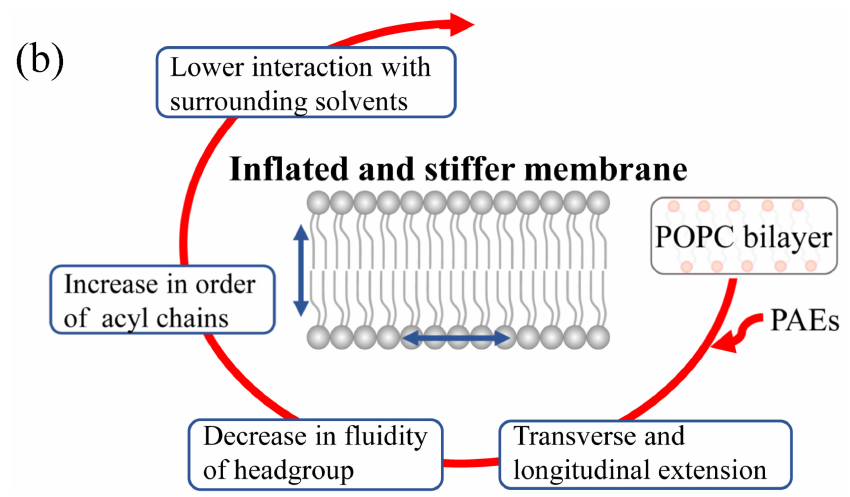
Figure 10. Molecular mechanism of membrane response to PAEs penetration. ( a ) Permeation pathway of PAEs with two distinct inserting modes. ( b ) A summary of the effects of PAEs on the lipid